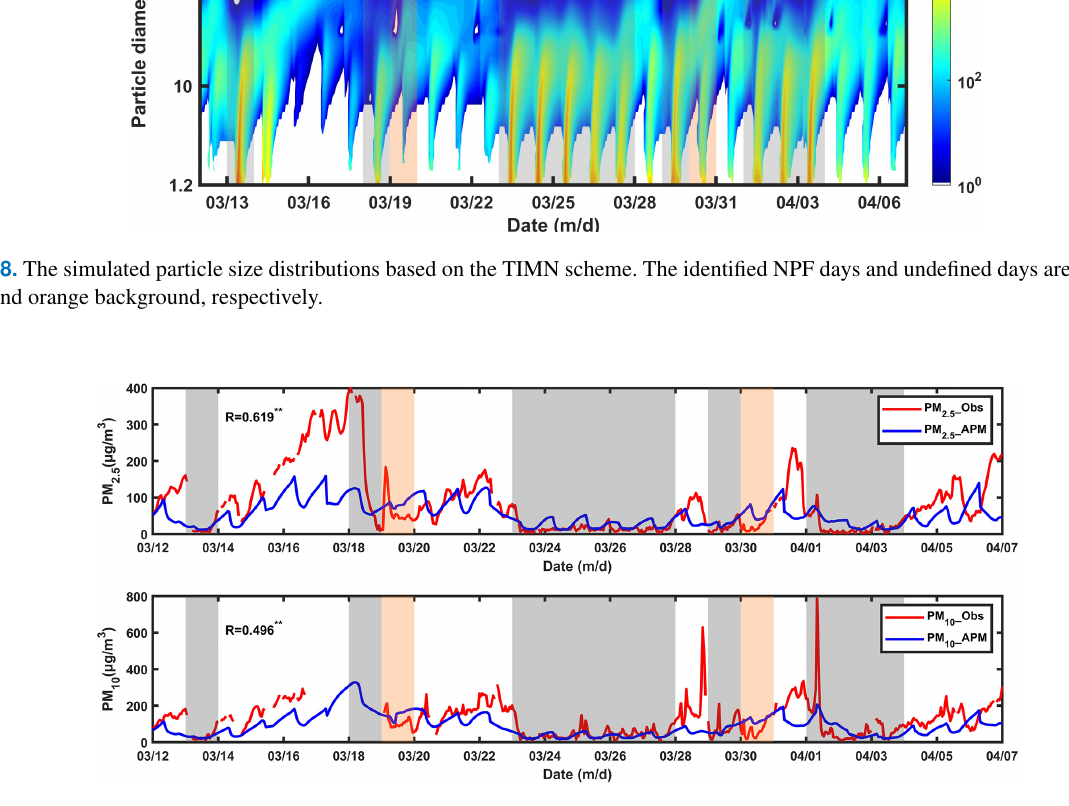
Figure 9. Comparison of observation PM 2 . 5 and PM 10 mass concentrations with those in the simulation based on the APM model during the measurement period. The identified NPF days and undefined days are shaded with a grey and orange background, respectively. ∗∗ The correlation coefficient passes the statistical significant test ( p < 0 .